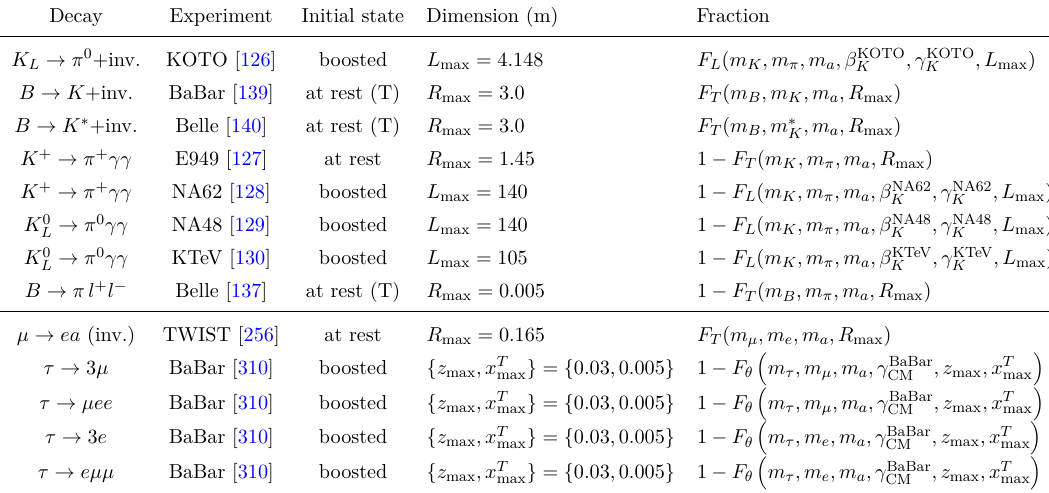
Table 11 . Summary of maximum/minimum ALP decay lengths for relevant experiments, and the fraction of ALPs that pass the decay length cuts, in terms of the F functions given in the text. “At rest (T)” means that the initial state is at rest in the transverse plane of the experiment.